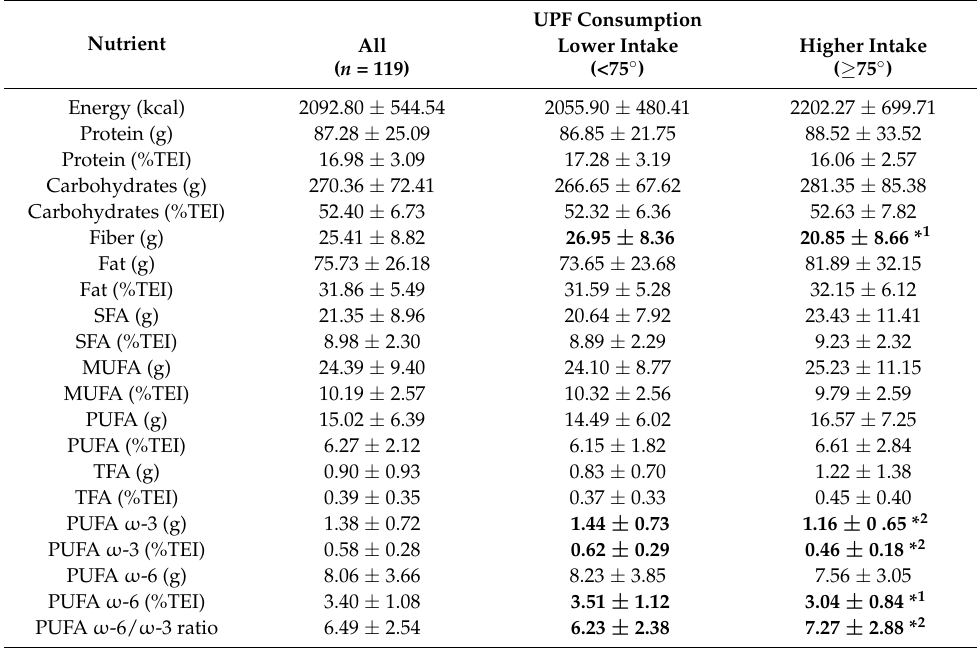
Table 2. Mean energy and macronutrient intake during pregnancy in all women and according to ultra-processed food